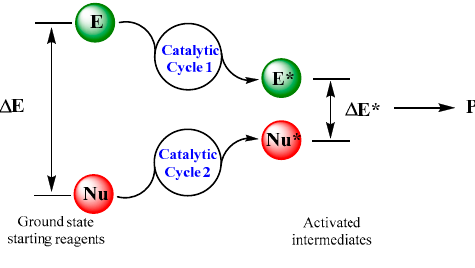
Figure 2. Synergistic catalysis.